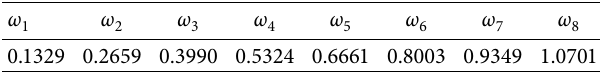
Table 2: Natural frequencies of